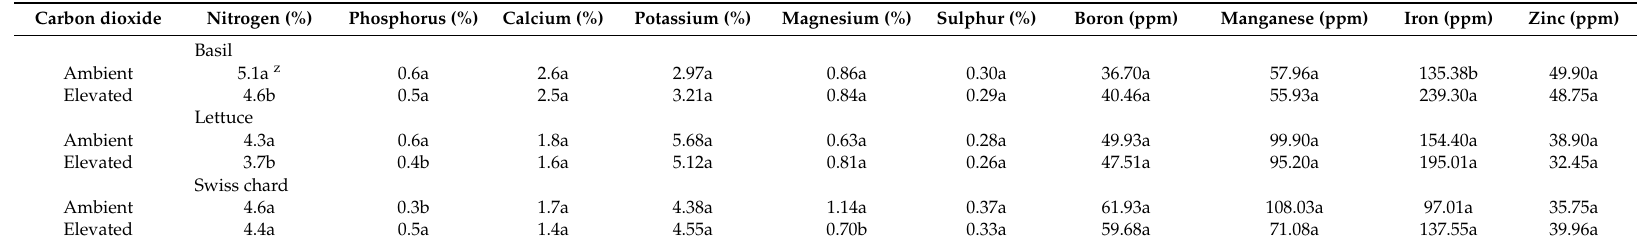
Table 2. E ff ect of CO 2 treatments (ambient at 400 ppm and supplemented at an average of 800 ppm) on mineral element concentrations of lettuce ‘Auvona’, Swiss chard ‘Magenta Sunset’, and basil ‘Cardinal’ grown under nutrient film technique (NFT) in Stillwater, OK, USA in 2016 and